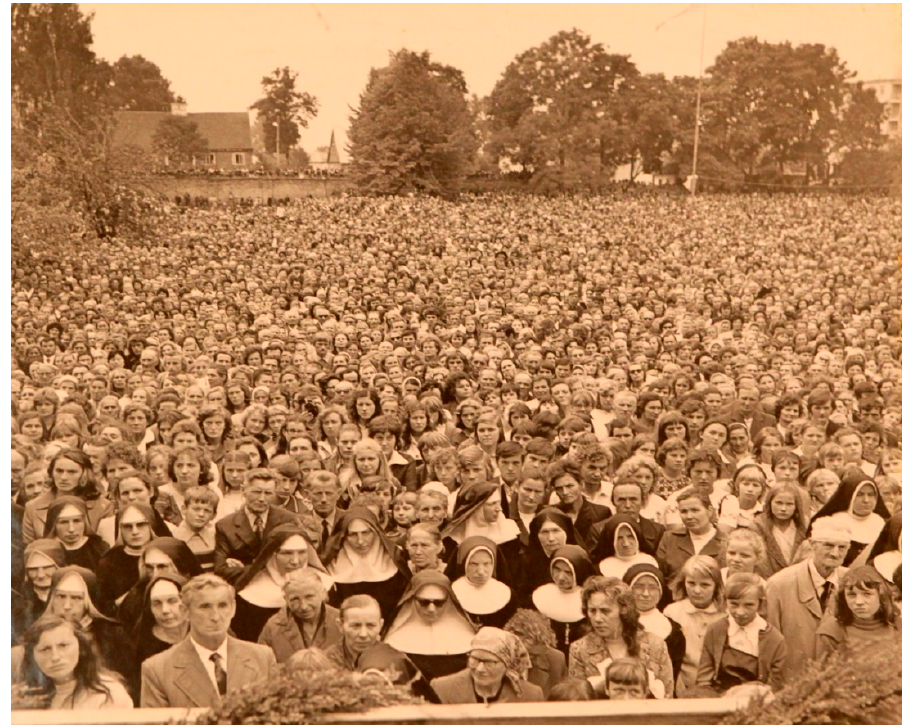
Figure 13. Over 60,000 pilgrims took part in the coronation ceremony of the statue of Our Lady of Sejny in Sejny (6 September 1975) (photo: Archive of the Sanctuary of Our Lady of Sejny in Sejny).